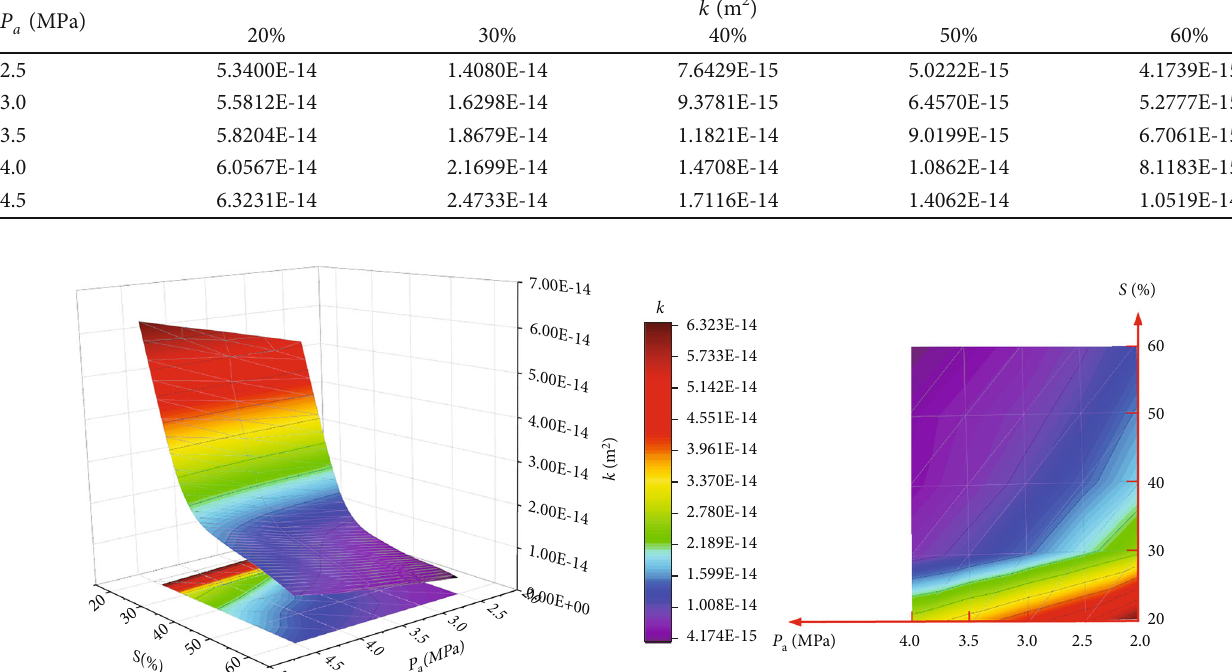
ff erent clay mineral proportions S a under di